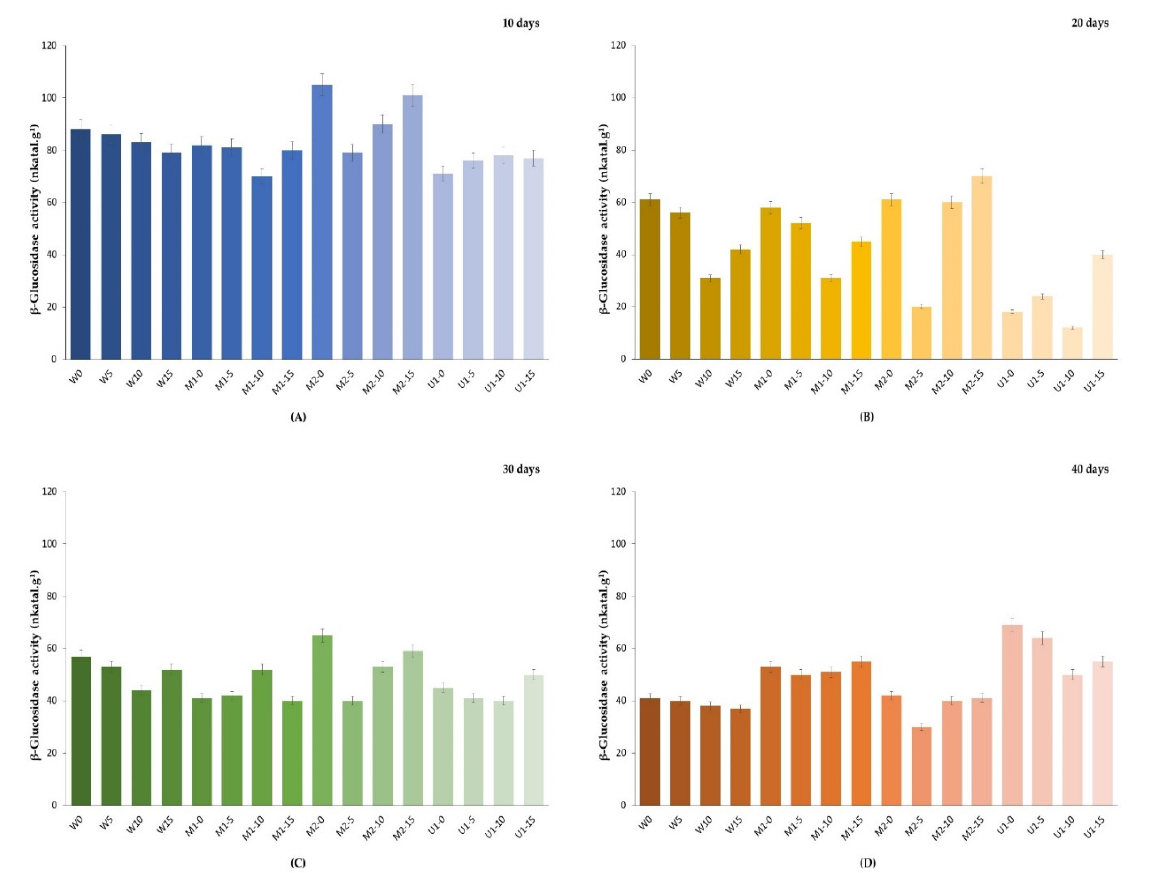
Figure 2. Changes in β -glucosidase activity during the curing process of vanilla pods treated with microwave and ultrasound technologies (nkatal.g − 1 fresh weight). W, pods immersed in a container with water. M1, pods immersed in a container with water in a microwave oven. M2, moistened pods placed on the microwave oven plate. U1, pods immersed in an ultrasonic bath. All experiments with additional ultrasound treatment at different times (0, 5, 10, and 15 min). ( A ) After 10 days of curing, ( B ) after 20 days of curing, ( C ) after 30 days of curing, and ( D ) after 40 days of curing.